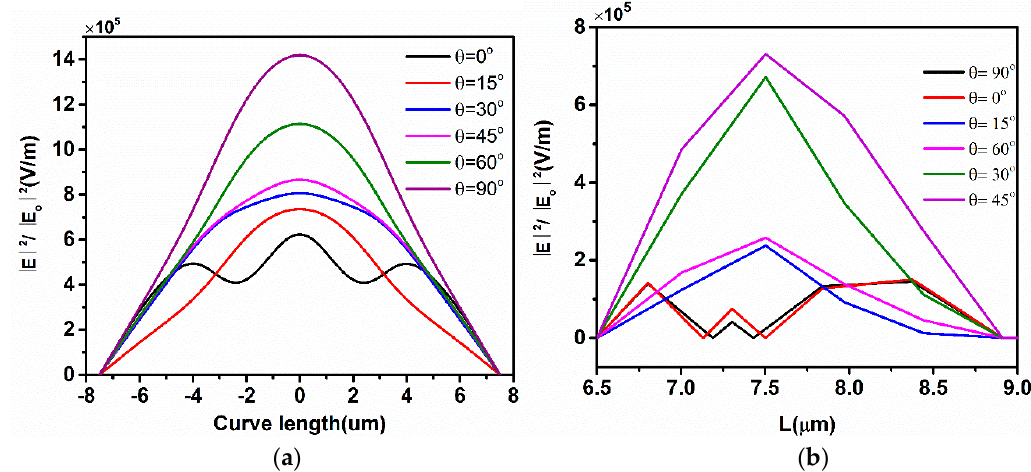
Figure 17. ( a ) Electric field intensity at the center gap of the antenna with incidence angle, and ( b ) Electric field intensity at the top surface of the antenna with respect to incidence angle.